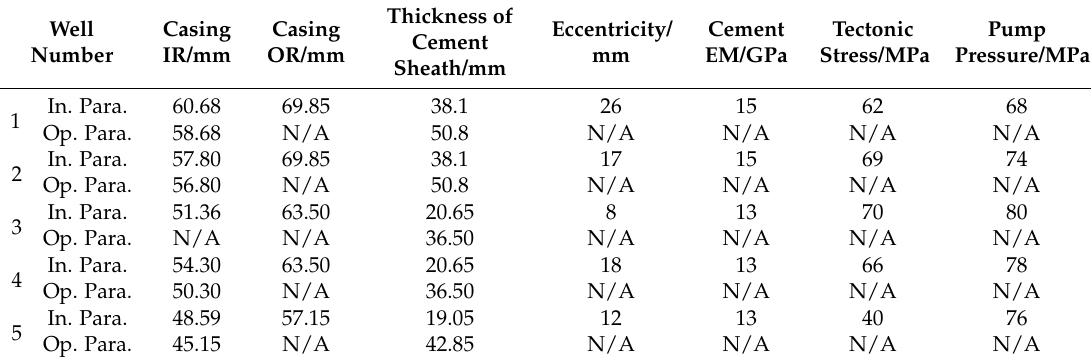
Table 3. Initial and optimized parameters of casing and cement sheath in shale gas wells.